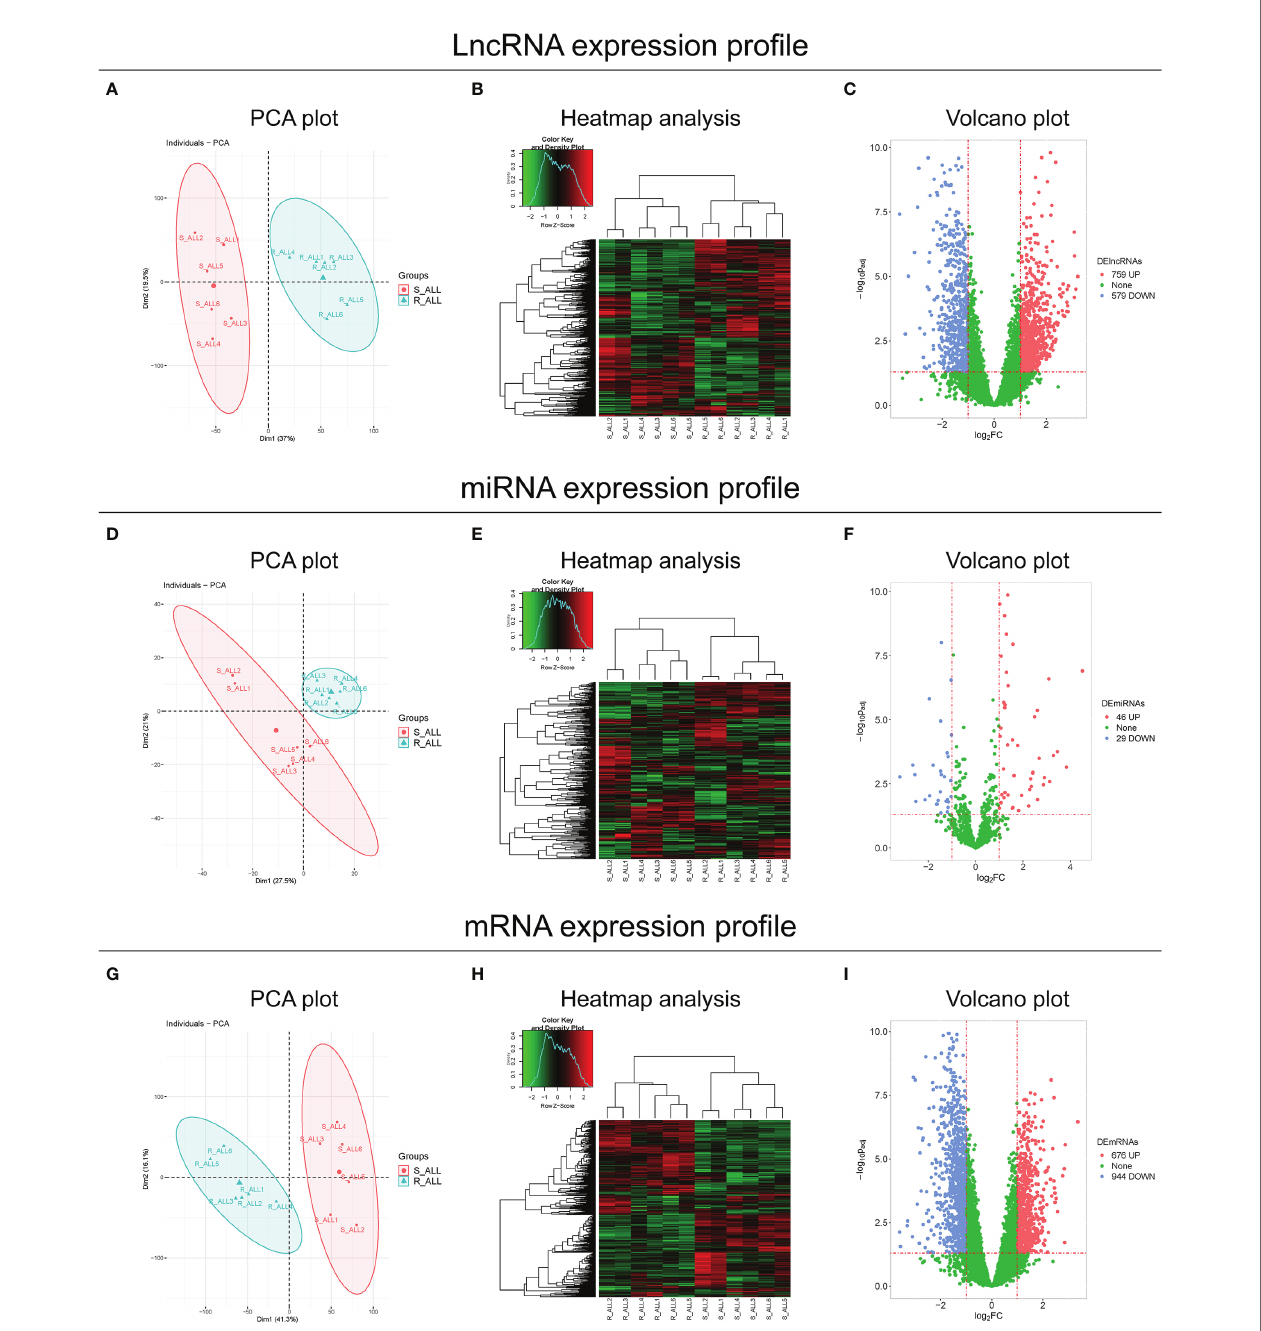
FIGURE 1 | PCA, heatmap, and volcano analyses of RNA sequencing. PCA plot and heatmap analyses of the lncRNA expression pro fi le, and volcano analysis of dysregulated lncRNAs between R-ALL and S-ALL patients (A – C) . PCA plot and heatmap analyses of the miRNA expression pro fi le, and volcano analysis of dysregulated miRNAs between R-ALL and S-ALL patients (D – F) . PCA plot and heatmap analyses of the mRNA expression pro fi le, and volcano analysis of dysregulated mRNAs between R-ALL and S-ALL patients (G – I) . The data were from the comparison of diagnostic B-ALL